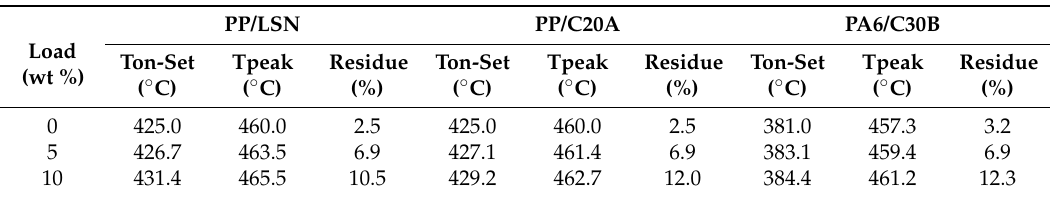
Table 2. The effect of the nanoparticle charges on the onset temperature and degradation peak temperature in the nanocomposites (20 ◦ C/min, N 2